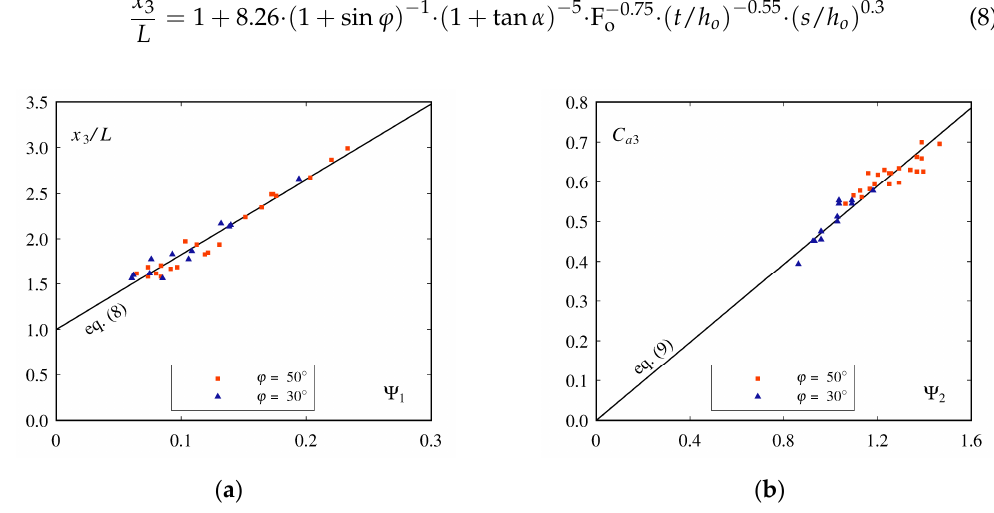
Figure 9. Spray maximum characteristics: ( a ) relative streamwise position x 3 / L as a function of Ψ 1